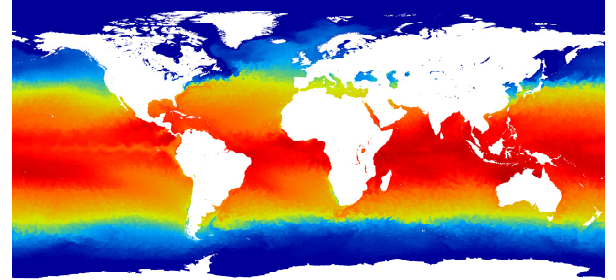
Figure 2. OSTIA SST data (www.metoffice.gov.uk, assessed on 24 November 2021).